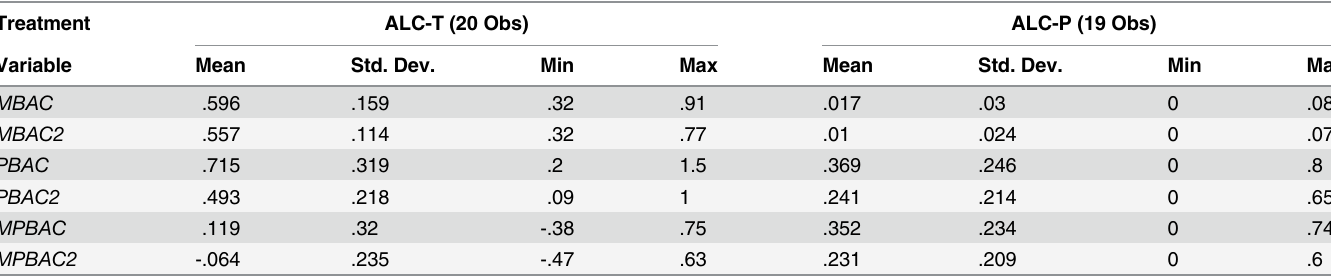
Table 2. Measured and Perceived BAC by Treatment. Treatment